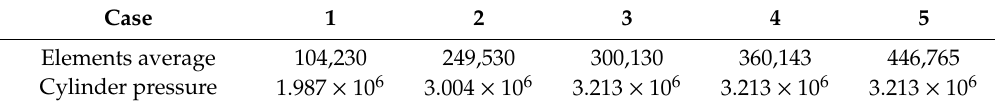
Table 3. Grid independence test summary.